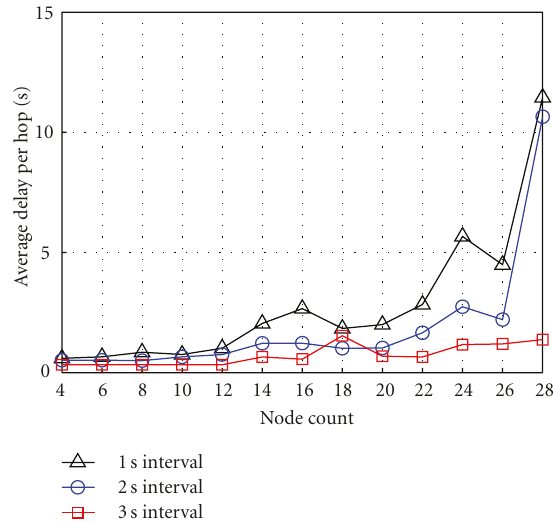
Figure 14: Average delay per hop as a function of node